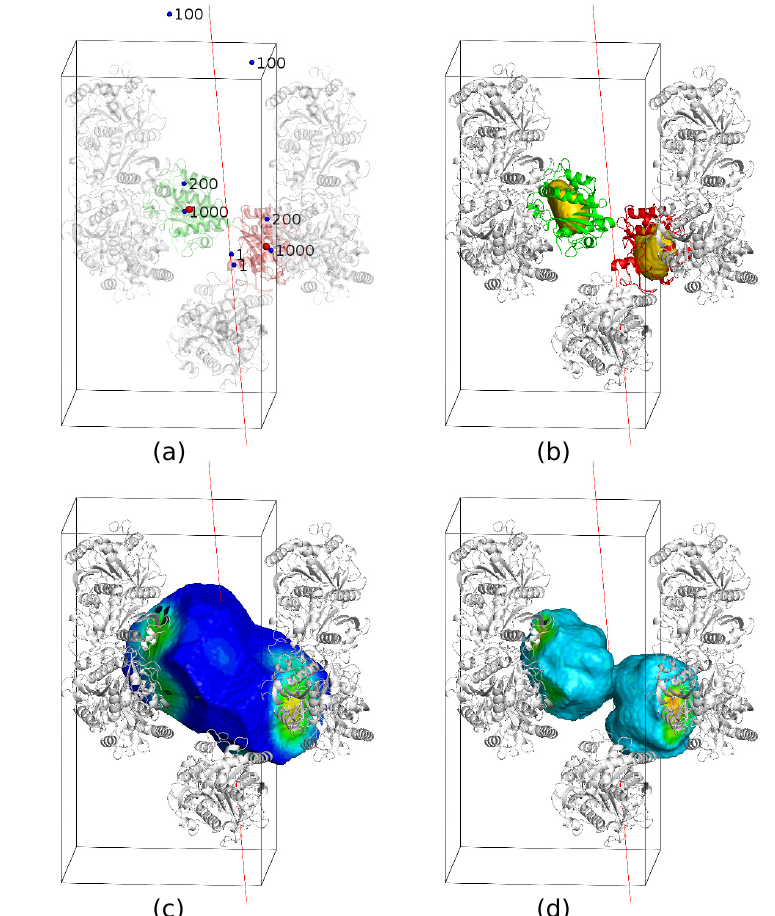
Figure 14. The calculated centroids, core, ASU, and protein boundary of 5AP9 from a typical successful